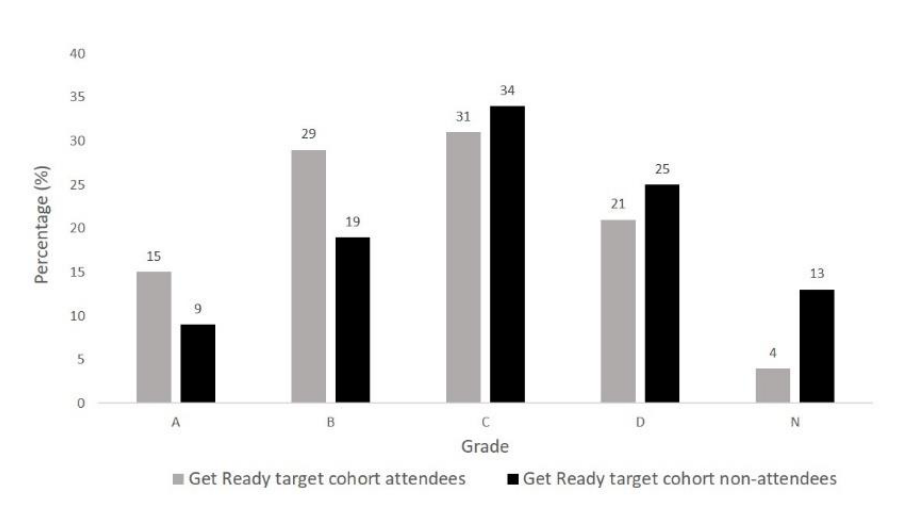
Performance of target cohort Get Ready attendees vs. non-attendees